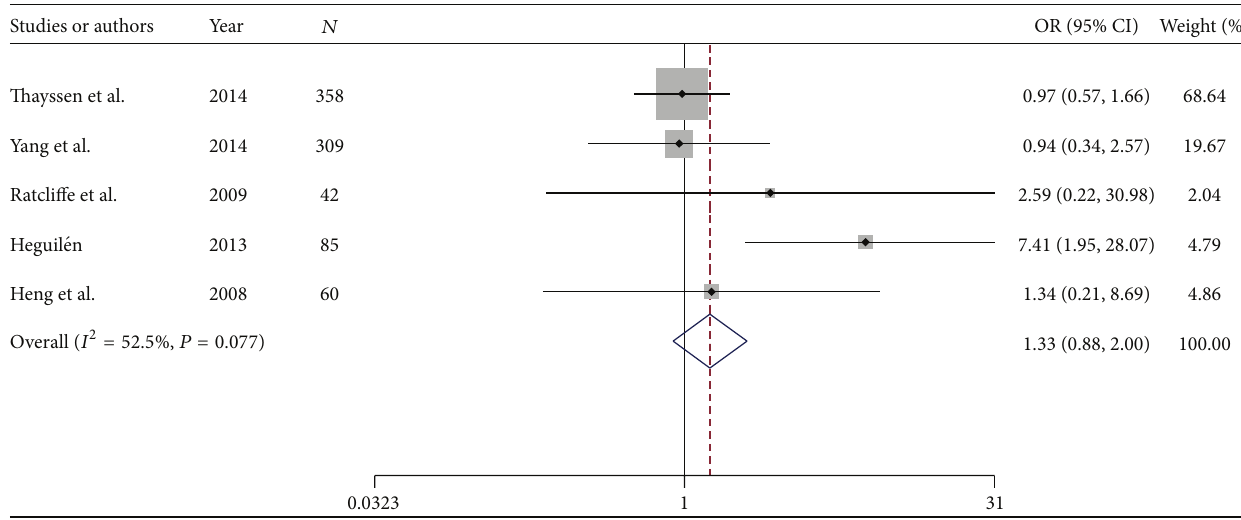
Figure 4: Forest plot of odds ratio (OR) for treatment with N-acetyl cysteine and hydration with sodium bicarbonate on contrast-induced